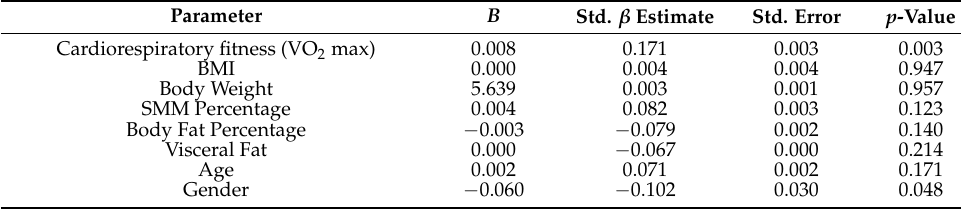
Table 5. Linear regression analysis of the predictors of attendance